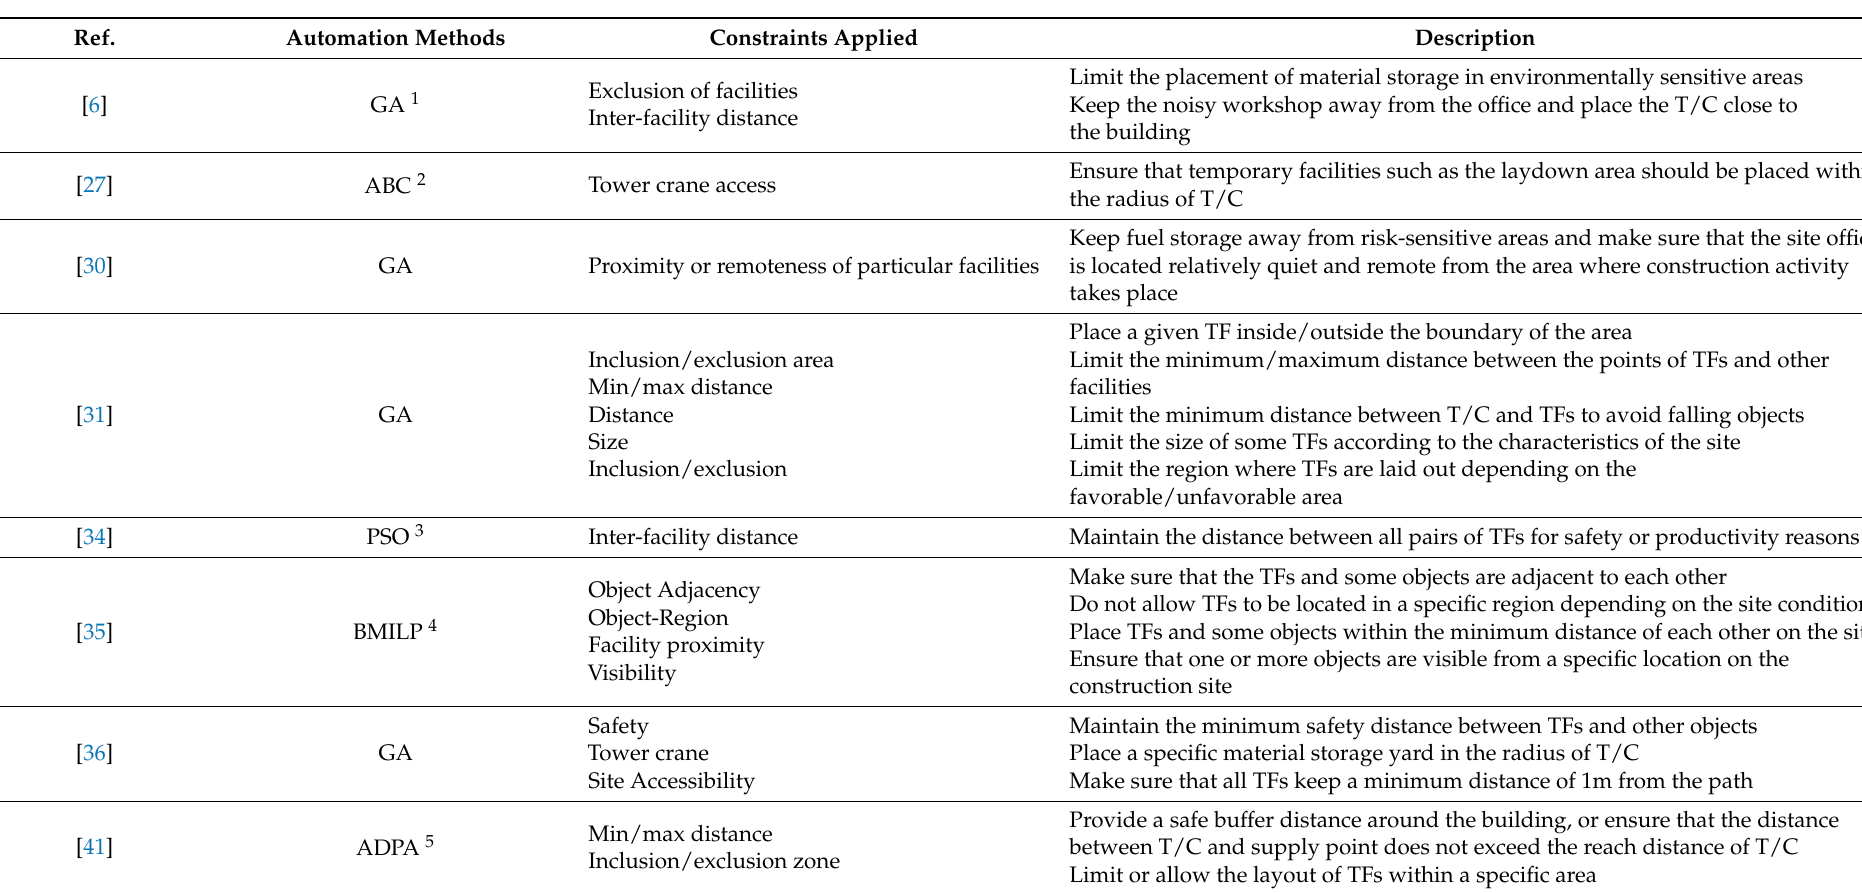
Table 1. Some CSLP automation models and constraints applied in the models except boundary and overlap constraints.